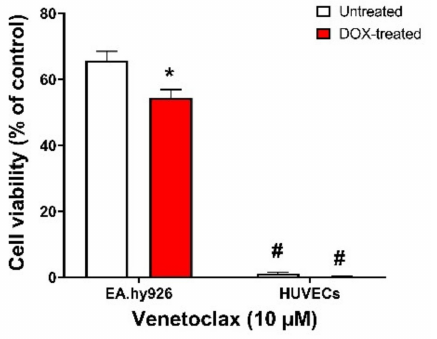
Figure 8. EA.hy926 cells and HUVECs respond differently to the BCL-2-selective inhibitor venetoclax. Both EA.hy926 cells and HUVECs were treated with DOX (0.5 µ M) for 24 h to establish the senescence phenotype or left untreated. Three days post DOX exposure, DOX-treated and untreated cells were incubated with 10 µ M venetoclax for 24 h. Thereafter, the cell viability was measured using MTT assays in both cell lines. The cell viability was calculated relative to control wells and expressed as a percentage. Note: * p < 0.05, compared to untreated treatment of the same cell line; # p < 0.05, compared to EA.hy926 cells of same treatment by two-way ANOVA with Tukey’s post hoc analysis. Values are presented as means ±